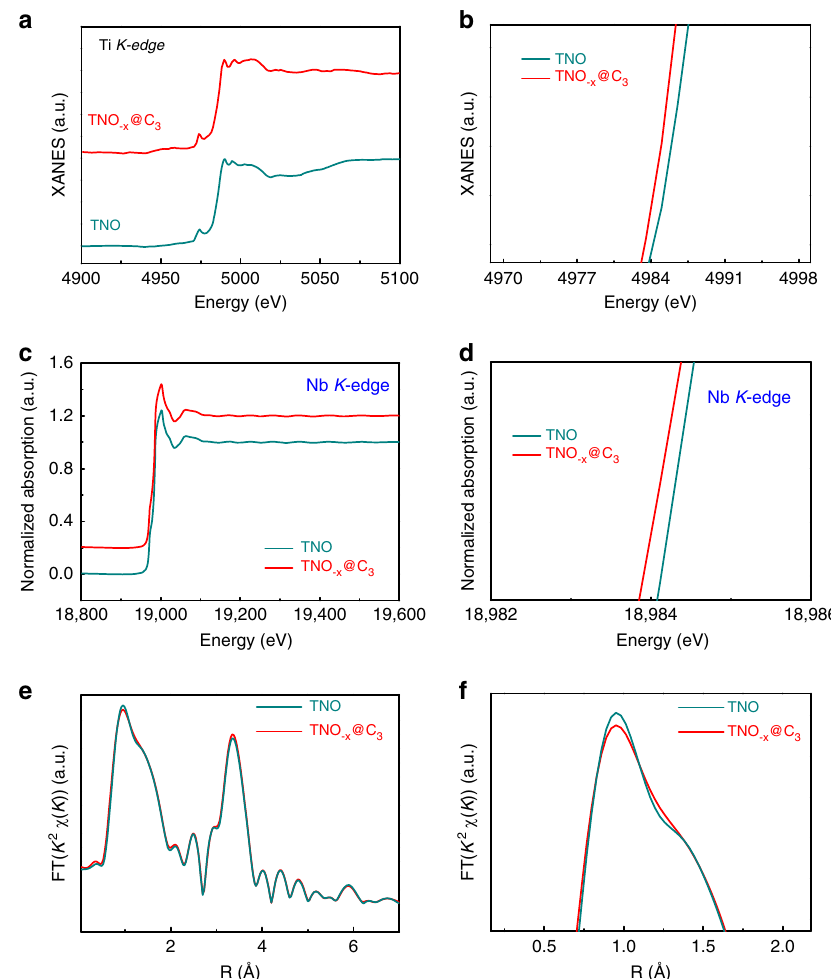
Fig. 3 XANES and XAFS spectra of pure TNO and TNO − x @C 3 samples. a Ti K -edge spectra. b Enlarged Ti K -edge spectra. c Nb K -edge spectra. d Enlarged Nb K -edge spectra. e Fourier transform of the k 2 -weighted Nb K -edge of the EXAFS spectra. f Fourier transform of the k 2 -weighted Nb K -edge of the enlarged EXAFS